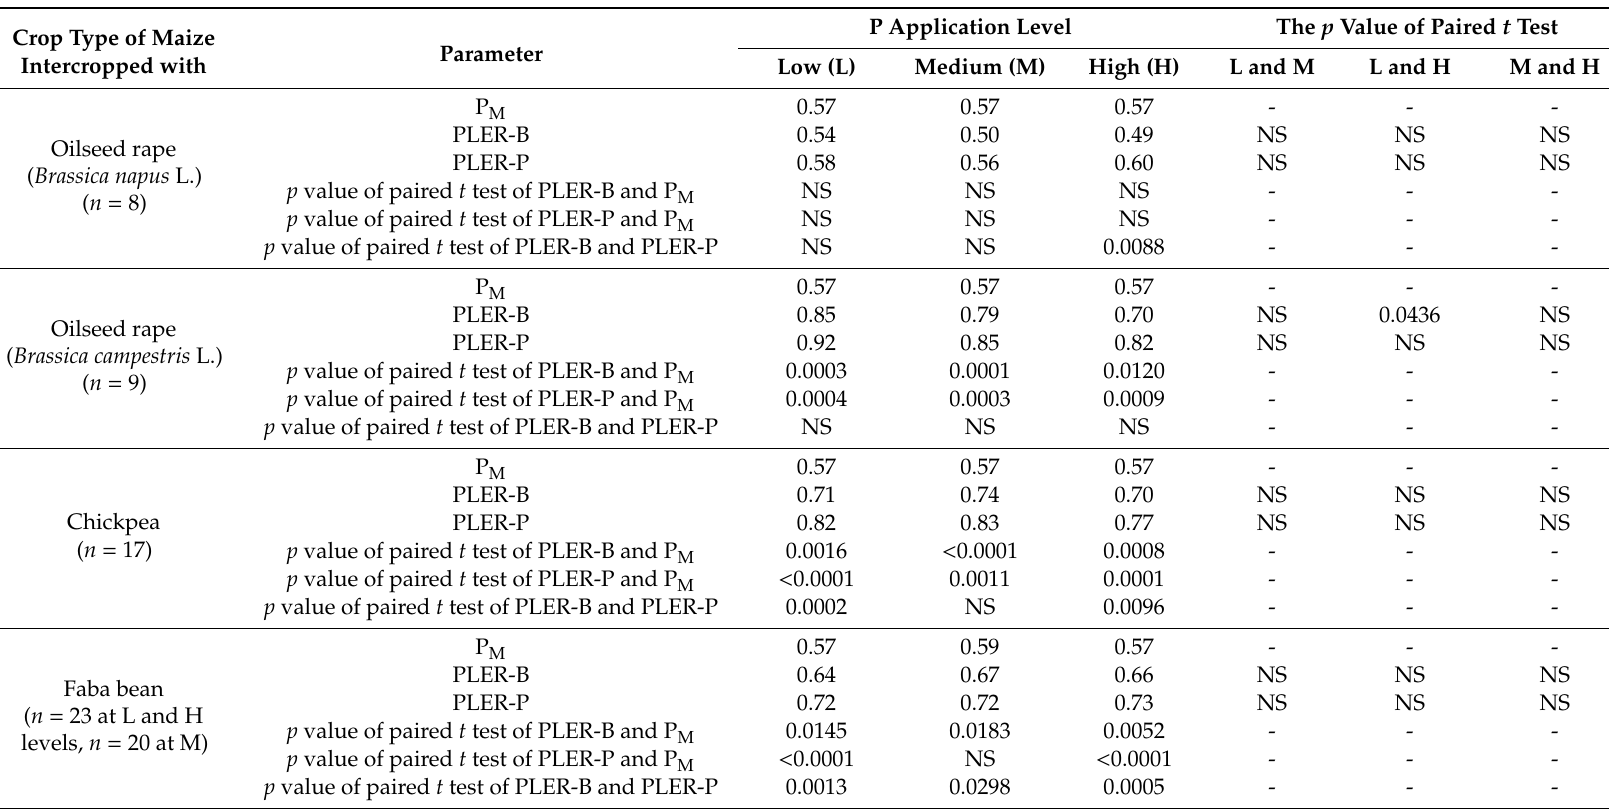
Table 8. Comparison of the partial land equivalent ratio (PLER) of shoot biomass (PLER-B) and shoot P content (PLER-P) of maize intercropped with di ff erent companion crops and the proportion of land area occupied by maize in the intercropping system (P M ) at di ff erent P application levels across all experimental sites and study